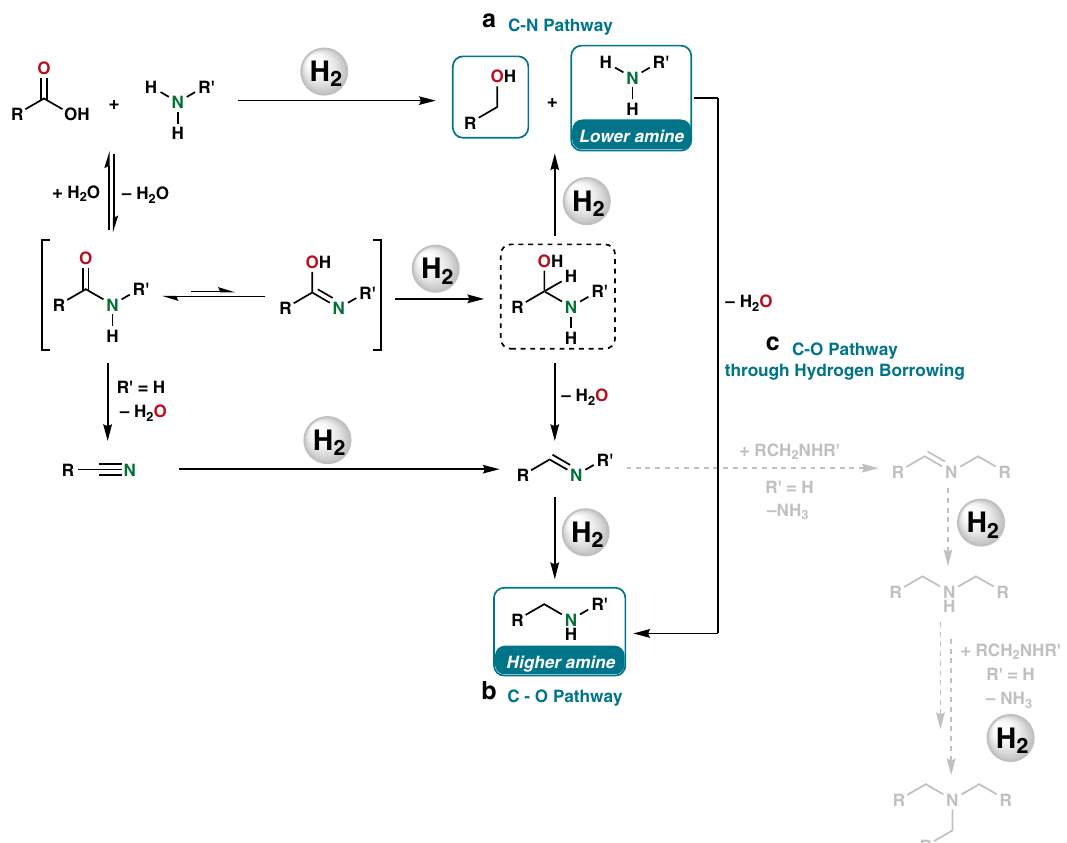
Fig. 1 Mechanisms proposed for amides hydrogenation. a C – N through hemiaminal or carboxylic acid intermediates; b C – O through hemiaminal or nitrile intermediates, (in gray byproducts formation from imine); c C – O through hydrogen